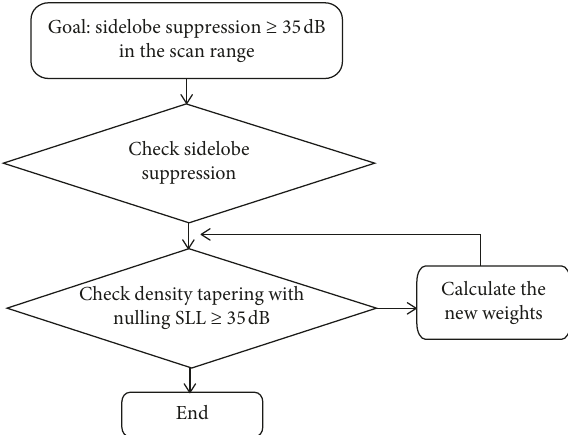
Figure 4: Iterative procedure of sidelobe suppression.